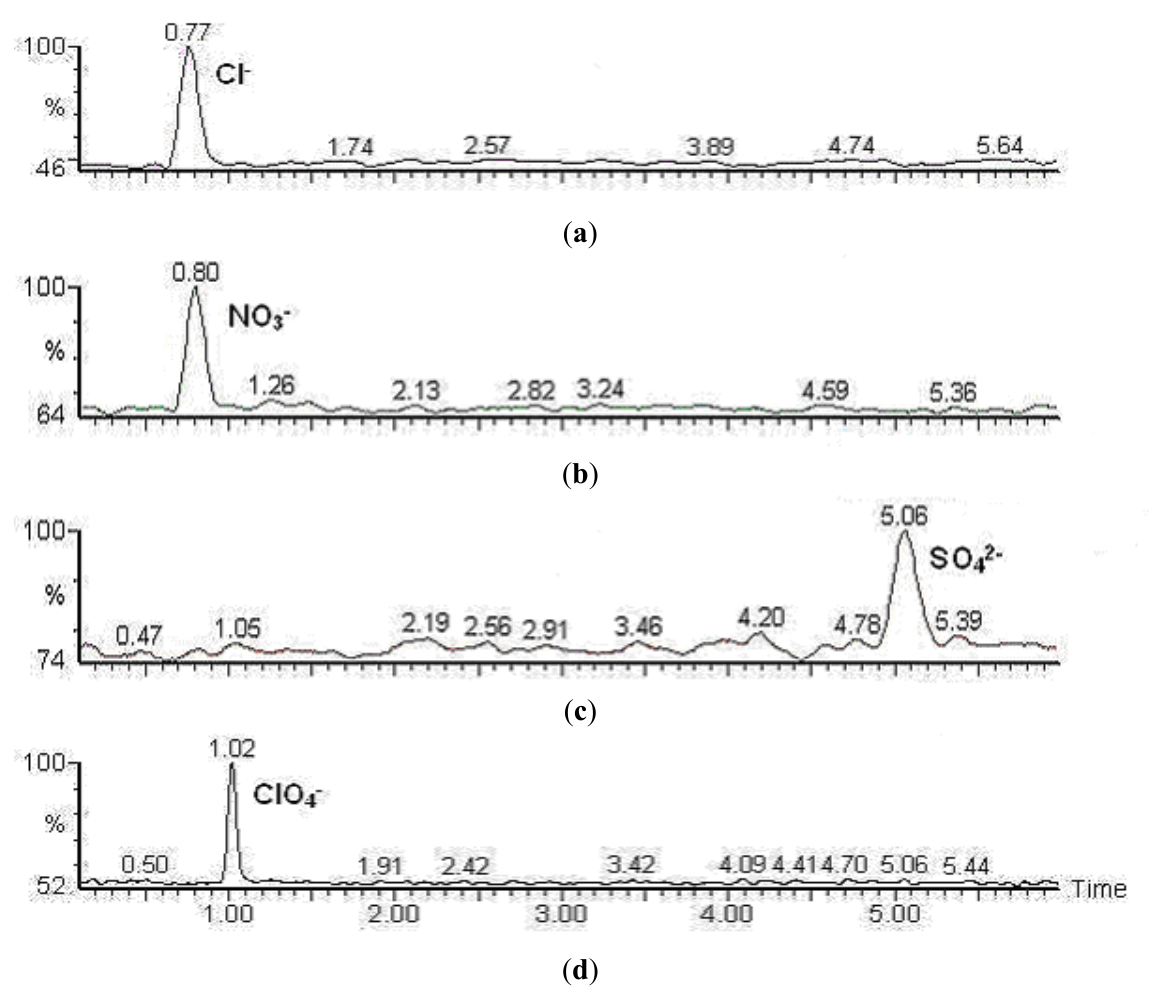
− : m / z 62 to 46; 3 − : m / z 99 to 4